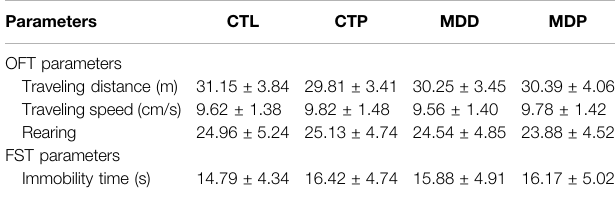
Abbreviation: OFT, open fi eld test; FST, forced swimming